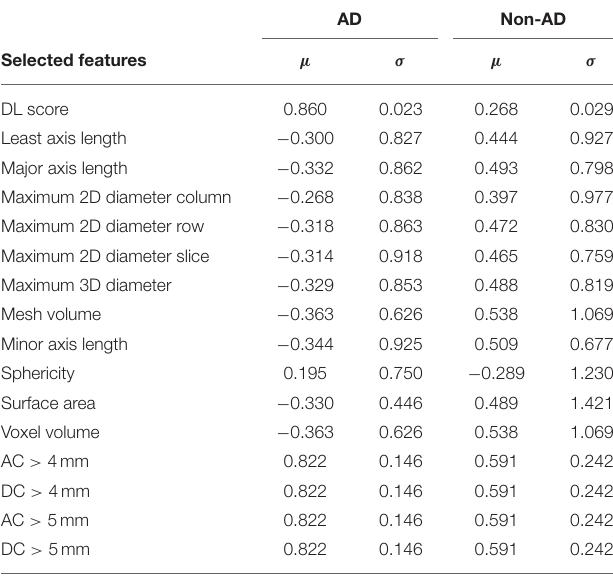
TABLE 3 | The list of selected features and the corresponding µ and σ coefficients of the trained deep-integrated model. AD Non-AD